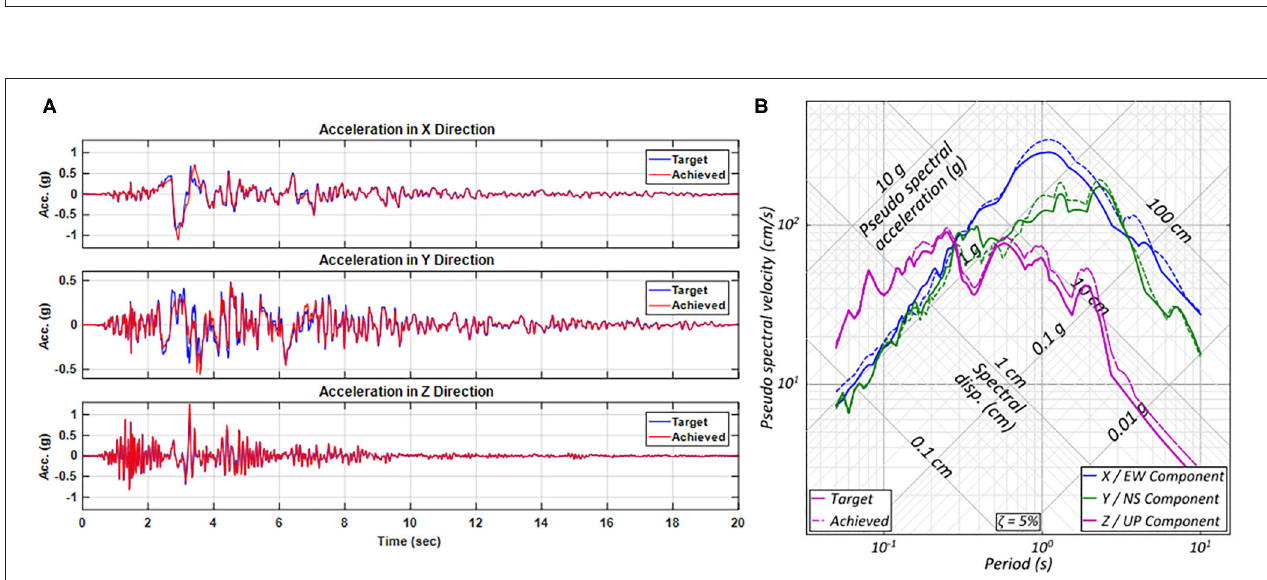
FIGURE 10 | Comparison of target and (simulated) achieved tri-axial 1994 Northridge earthquake record (see Table 2 ): (A) acceleration time histories, and (B) 5% damped tri-partite linear elastic response spectra.